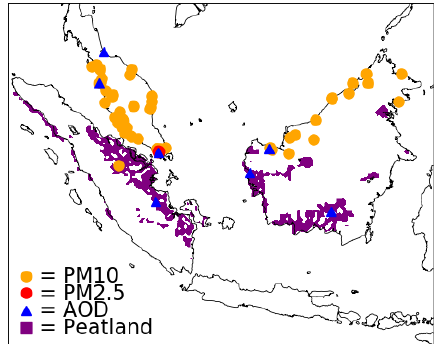
Figure 1. The study area showing the locations of PM 10 measure- ments in yellow circles, PM 2 . 5 in red circles and AOD in blue tri- angles. Peatland is shown in